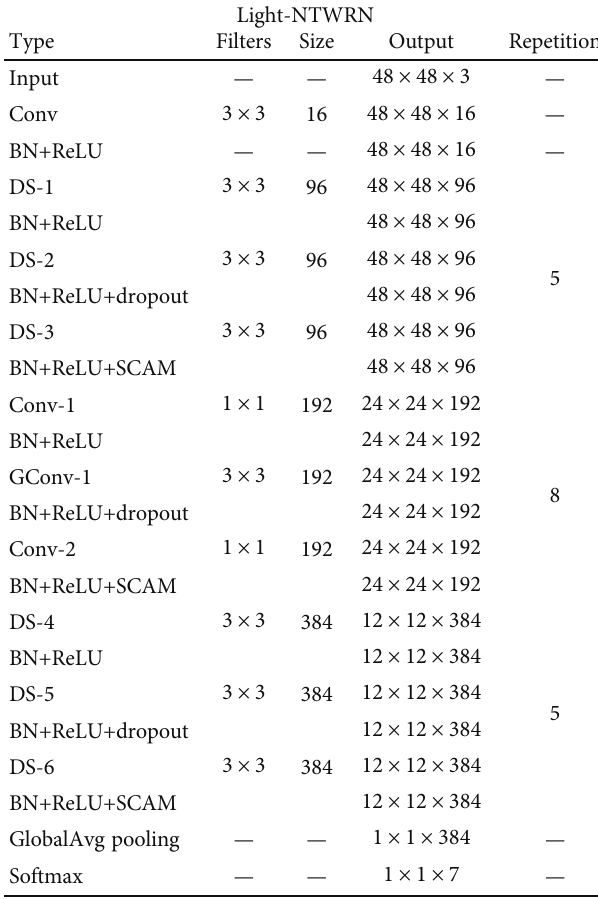
Table 1: Model parameters.